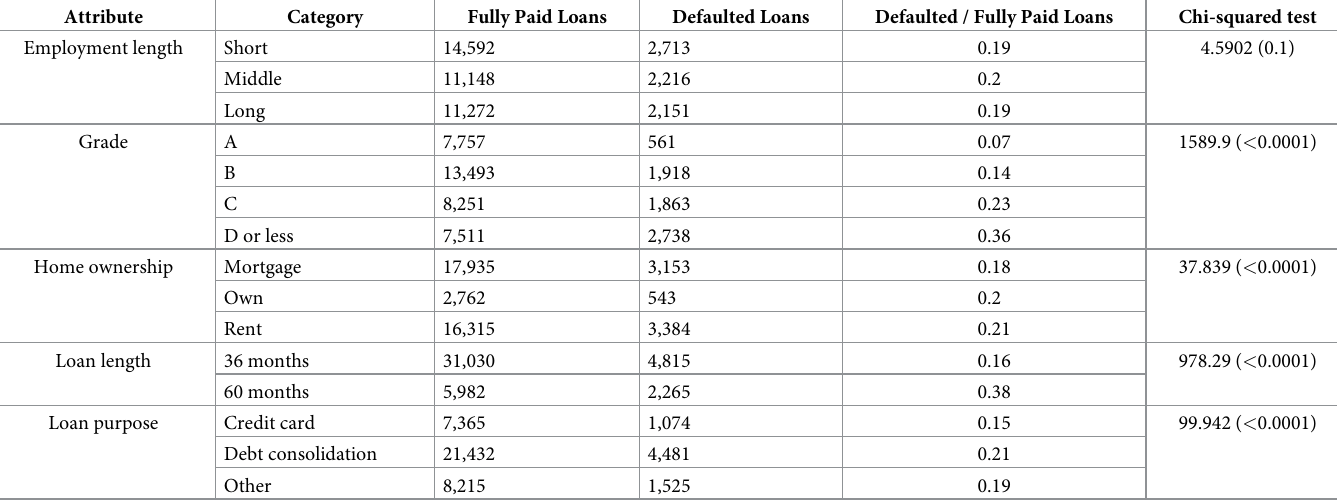
Table 3. Result of the chi-squared test for categorical